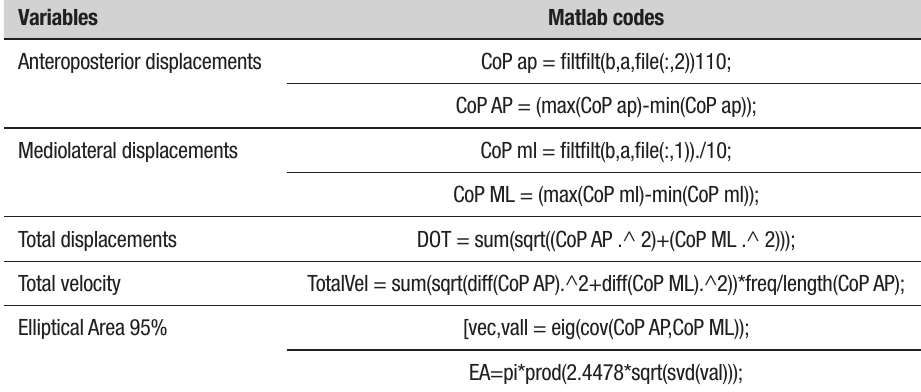
Table 1. Variables obtained from CoP and codes to calculate in Matlab.